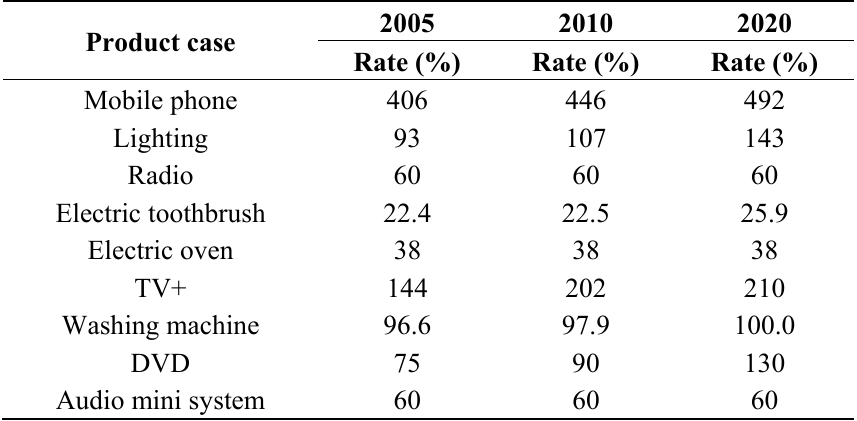
Table 1. Appliance penetration